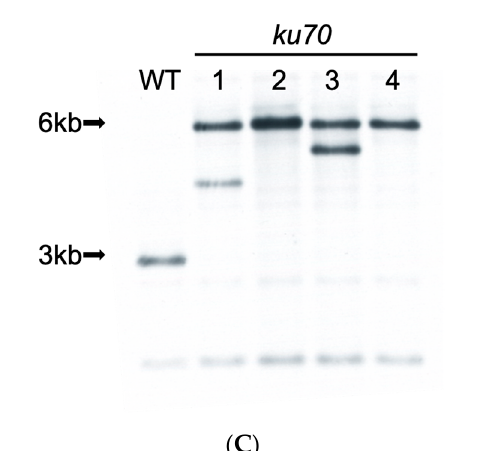
Figure 1. Phenotypic characteristics in a non-homologous end-joining-deficient strain ( ku70 ) of A. oligospora . ( A ) Colonies of TWF154 (WT) and independent ku70 strains grown on potato dextrose agar (PDA) plates (5-cm diameter) for 4 day at 25 °C (Scale bar, 1 cm). ( B ) Representative brightfield images of the traps induced by N2 C. elegans in the TWF154 (WT) and independent ku70 mutant strains. Images were taken 24 h after induction with N2 C. elegans (Scale bar, 200 µ m). ( C ) Southern blot confirmation of KU70 deletion. The wild-type TWF154 strain displayed a predicted band of size 2.9 kb, whereas ku70 mutants had predicted bands of 5.9 kb.